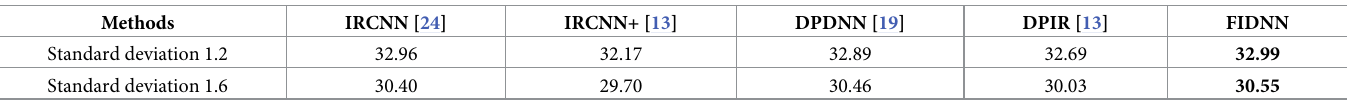
Table 6. Average PSNR results of Gaussian deblurring for different standard deviation by different methods on Kodak24 dataset. Methods IRCNN [24] IRCNN+ [13] DPDNN [19] DPIR [13] FIDNN Standard deviation 1.2 Standard deviation